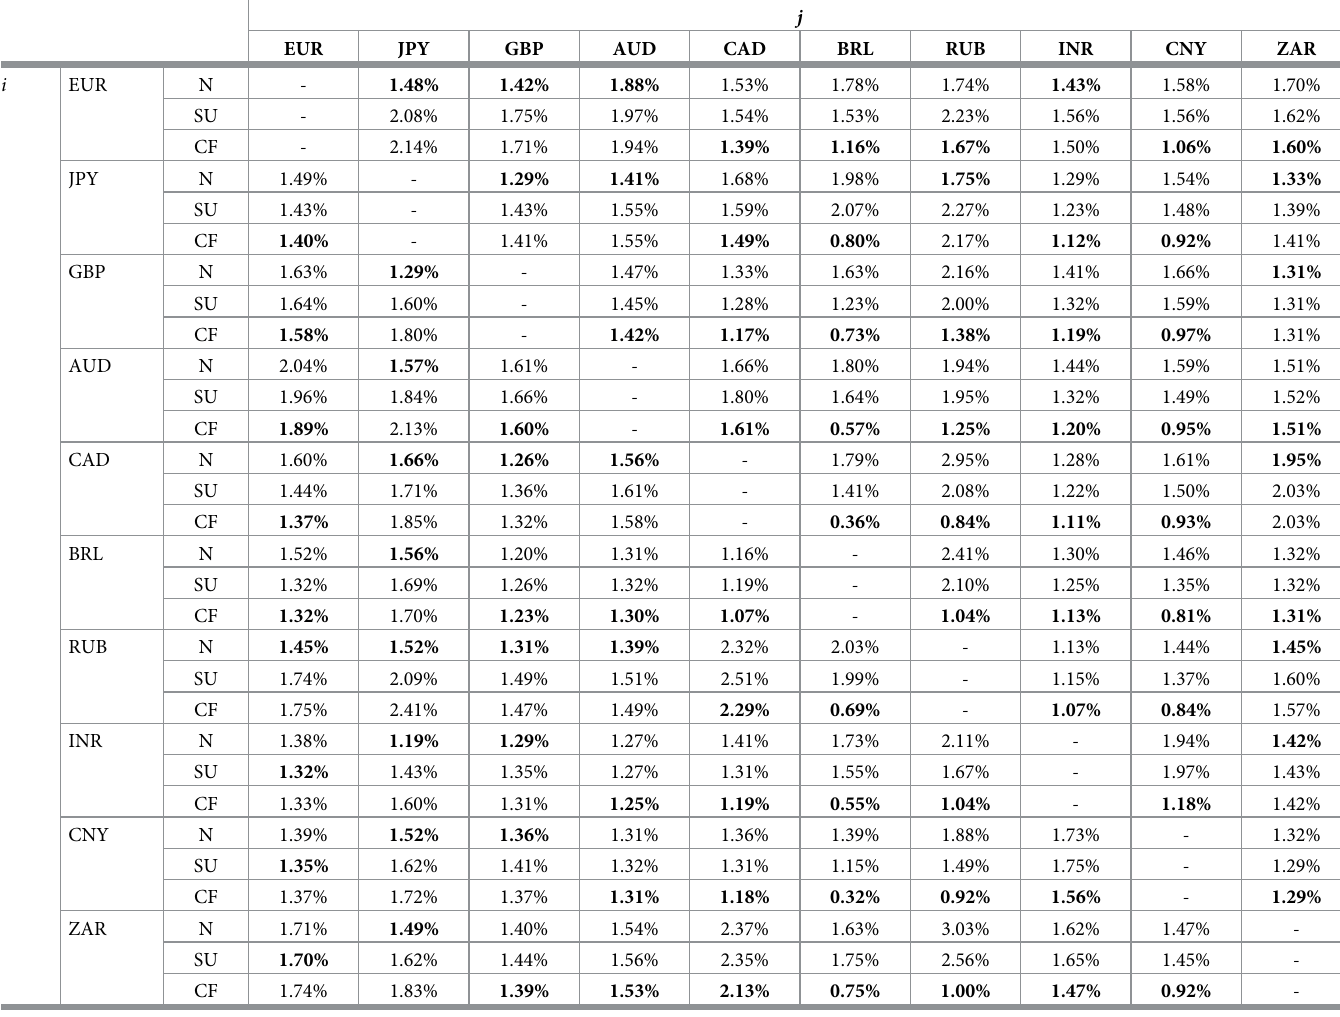
of the forecasted MCoVaR 5 % j j i ; n ij